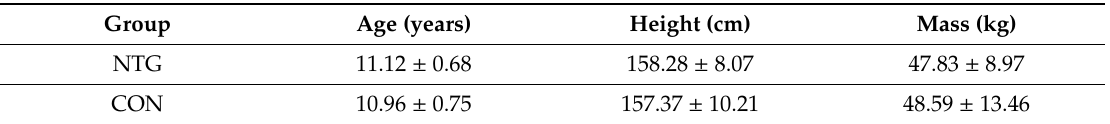
Table 1. Age, height, and weight data across